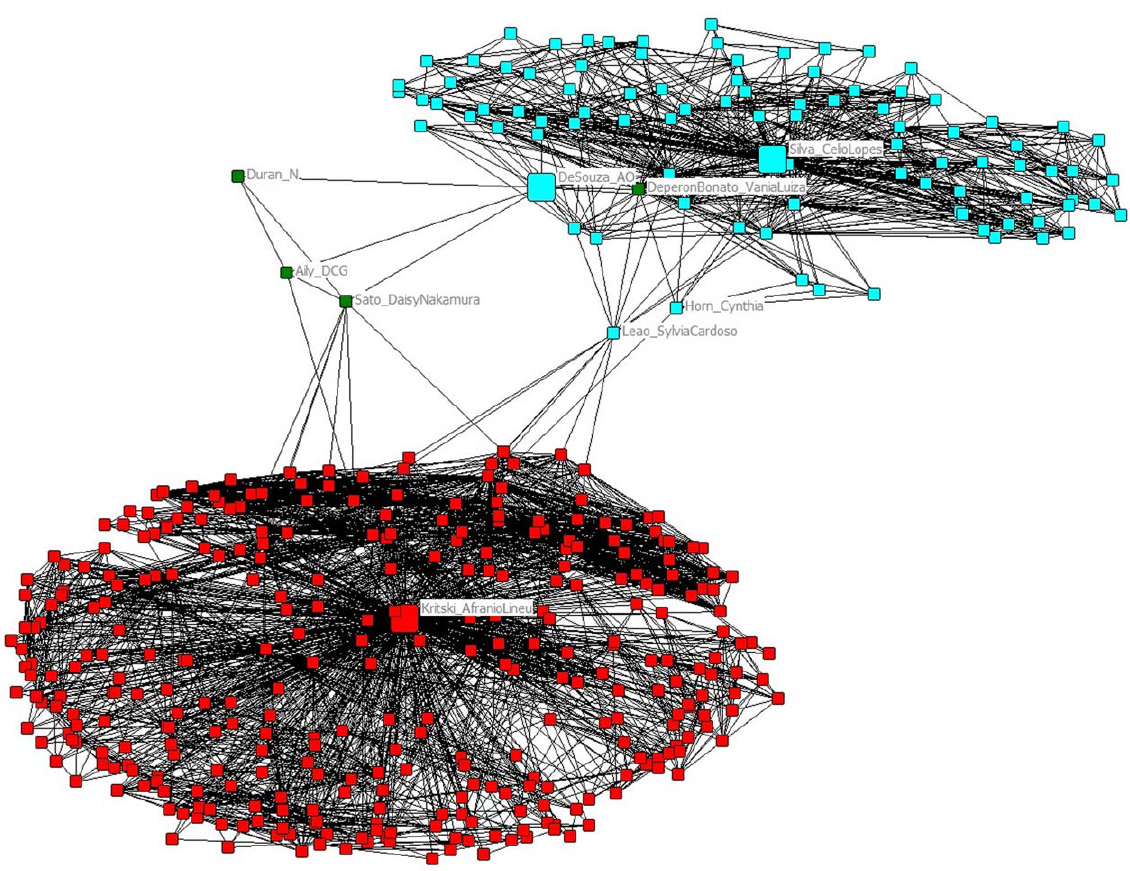
Figure 4. Co-authorship ego-network of the Brazilian scientists who published more papers (A. Kritsky) and filed more patent applications (C. Silva in collaboration with A. O. Souza) during the period 1995–2010.